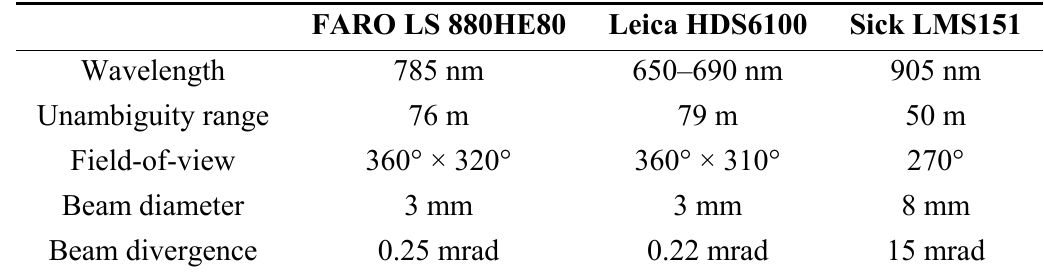
Table 2. Specifications for the TLS instruments used in the experiments. The Sick LMS 151 field of view is